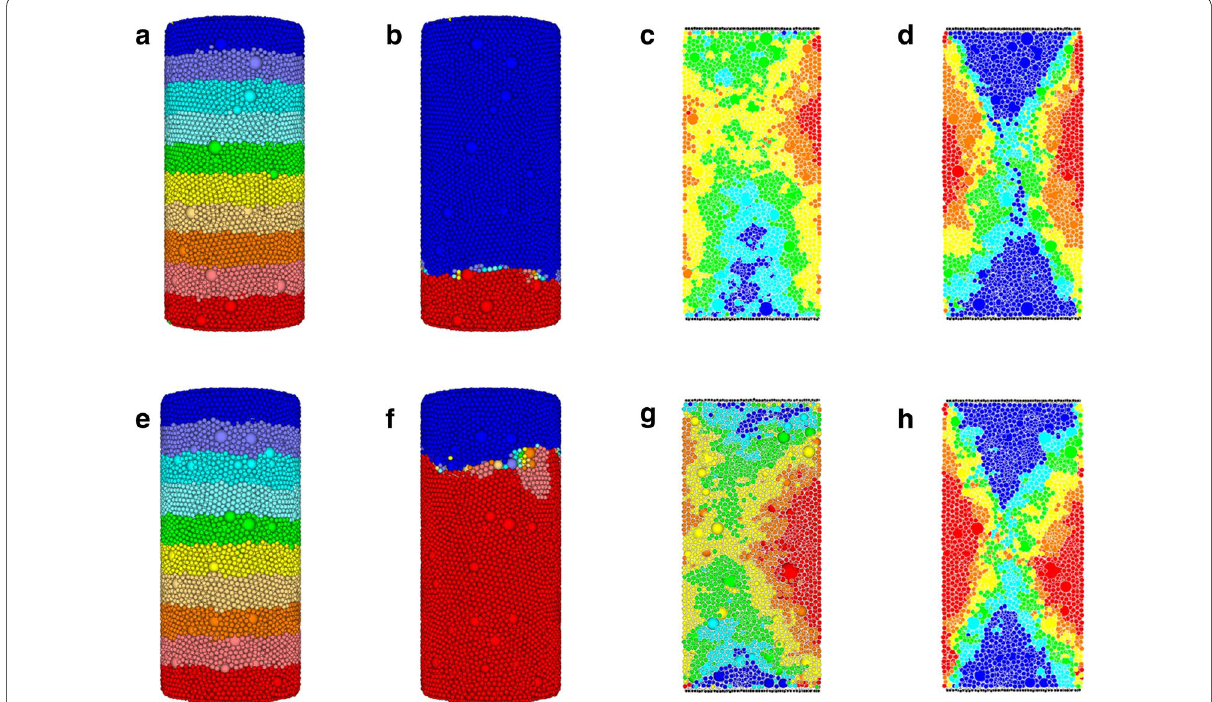
Fig. 12 Displacement nephograms of numerical models at different loading stages. a Pre-peak axial displacement nephogram (tension for Group CA). The particle’s color will be relatively close to blue while its tensile displacement is relatively large, b post-peak axial displacement nephogram (tension for Group CA). The particle’s color will be relatively close to blue while its tensile displacement is relatively large, c pre-peak radial displacement nephogram (compression for Group CA). The particle’s color will be relatively close to red while its radial displacement is relatively large (cutaway view), d post-peak radial displacement nephogram (compression for Group CA). The particle’s color will be relatively close to red while its radial displacement is relatively large (cutaway view), e pre-peak axial displacement nephogram (tension for Group CB). The particle’s color will be relatively close to blue while its tensile displacement is relatively large, f post-peak axial displacement nephogram (tension for Group CB). The particle’s color will be relatively close to blue while its tensile displacement is relatively large, g pre-peak radial displacement nephogram (compression for Group CB). The particle’s color will be relatively close to red while its radial displacement is relatively large (cutaway view), h post-peak radial displacement nephogram (compression for Group CB). The particle’s color will be relatively close to red while its radial displacement is relatively large (cutaway